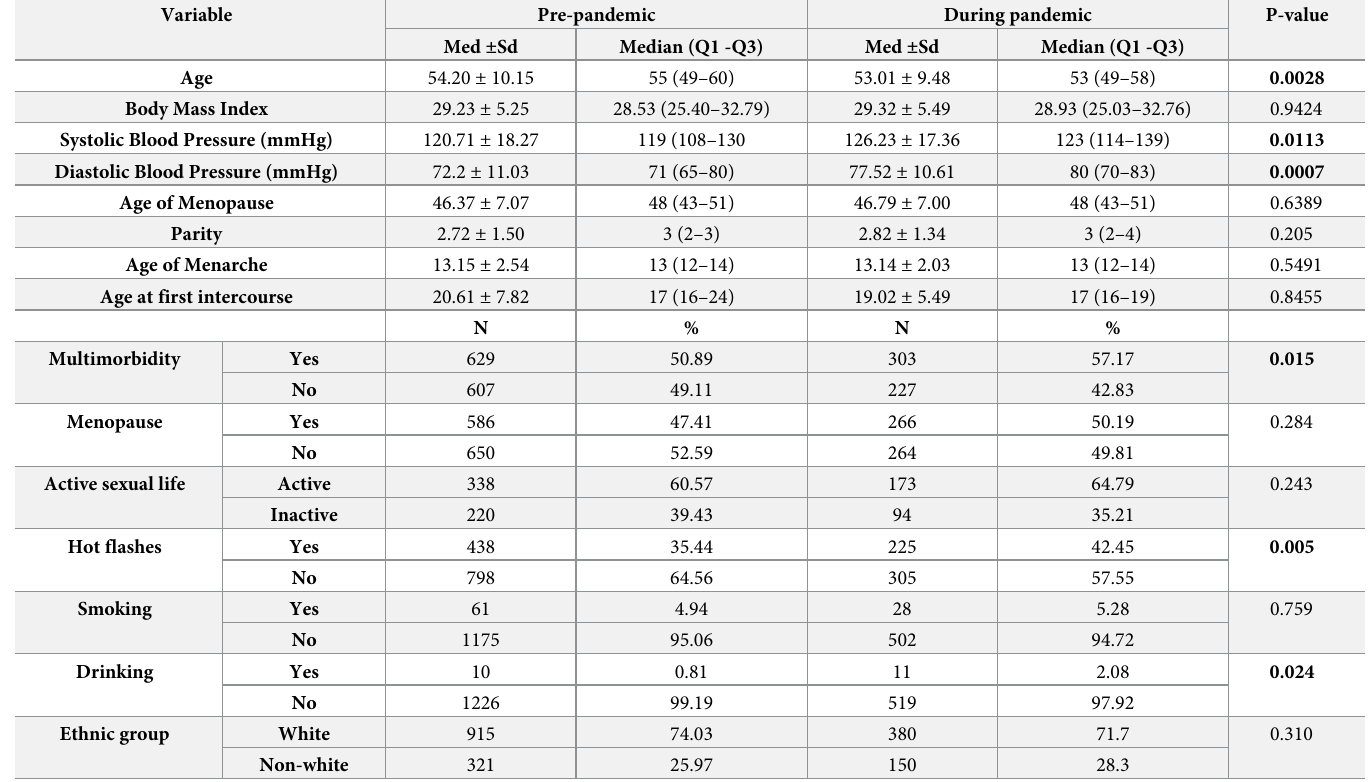
Table 1. Clinical-sociodemographic characteristics of women at the HCFMUSP gynecology outpatient clinic pre- and during pandemic.